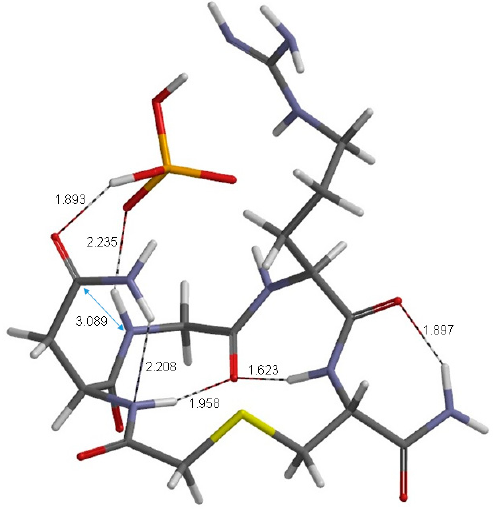
Figure 3. The geometry of the reactant complex (RC) formed between the cyclic peptide CP15 (in a deprotonated form as shown in Figure 1) and an H 2 PO 4 − ion. Selected interatomic distances are shown in Å. Grey: carbon; white: hydrogen; blue: nitrogen; red: oxygen; orange: phosphorus; yellow: sulfur.